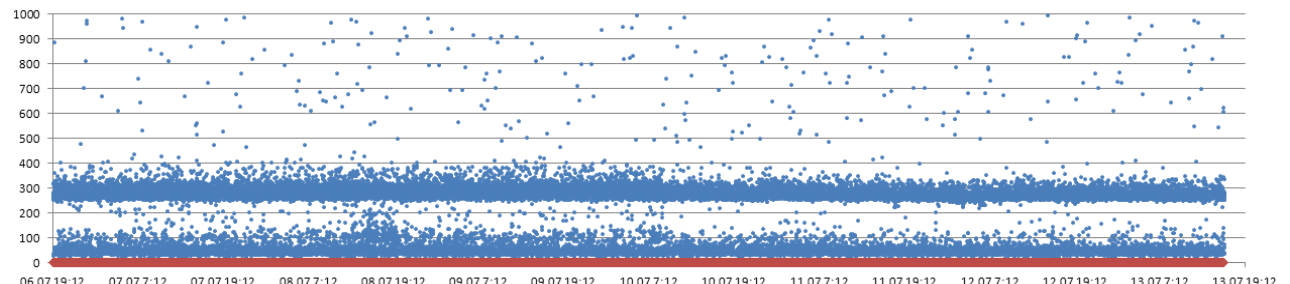
Fig. 5. RTT of Tele2 4G cellular network operator subsystem,